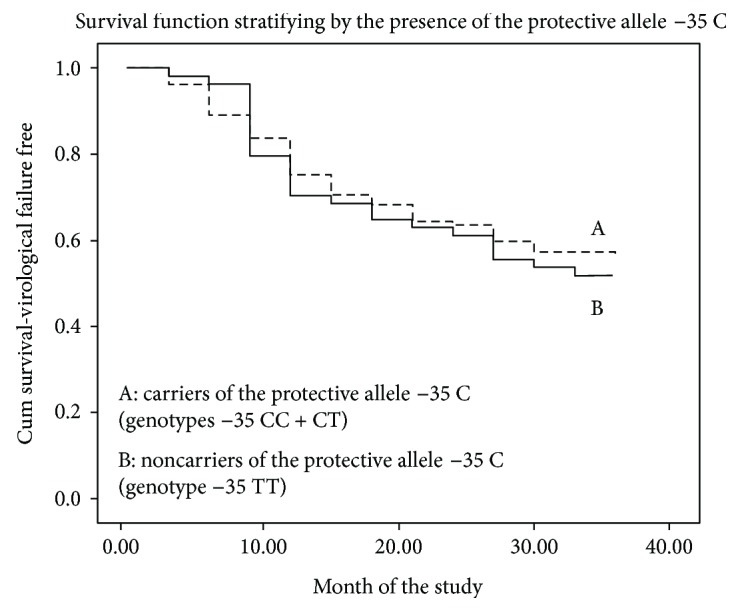
Kaplan-Meier estimates of virological failure-free survival during antiviral therapy according to the stratification by the presence of the protective allele −35 C (SNP rs9264942).